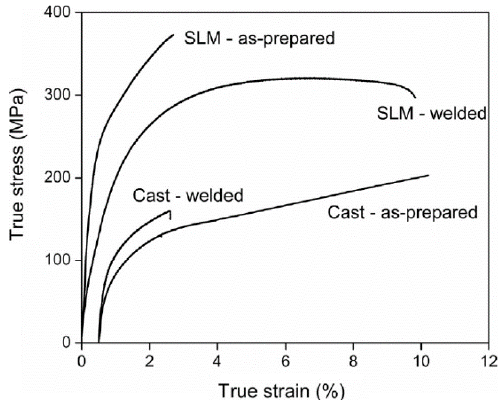
Figure 73. Room temperature tensile curves of the cast and SLM specimens tested in the as-prepared and welded conditions [216]. Copyright 2014. Adapted with permission from Elsevier Science